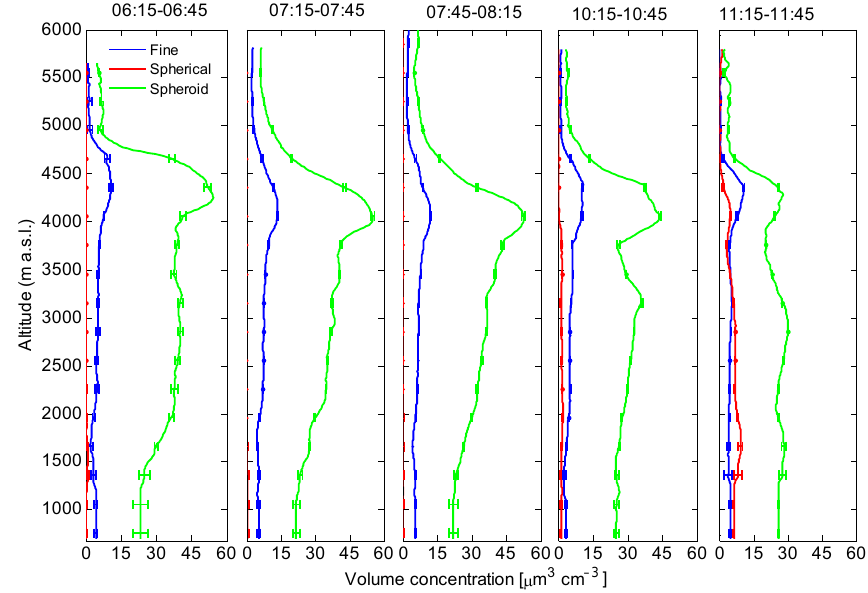
Figure 4. Volume concentration profiles of the fine, coarse spherical and coarse spheroid modes obtained with LIRIC from 30min averaged lidar data for different periods on the 27 June 2011. The error bars represent the uncertainty associated to the selection of the user-defined input parameters in LIRIC, obtained as indicated in Granados-Muñoz et al. (2014). Table 1. Aerosol properties on region 1, corresponding to the mixture of anthropogenic aerosol and mineral dust below 2250ma.s.l. and region 2, corresponding to the mineral dust particles located above 2250ma.s.l.